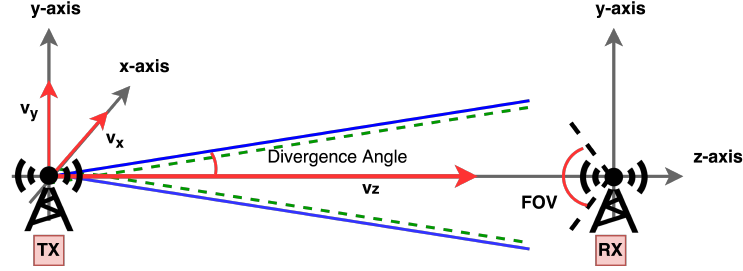
Figure 2. Optical beam transmission (Gaussian